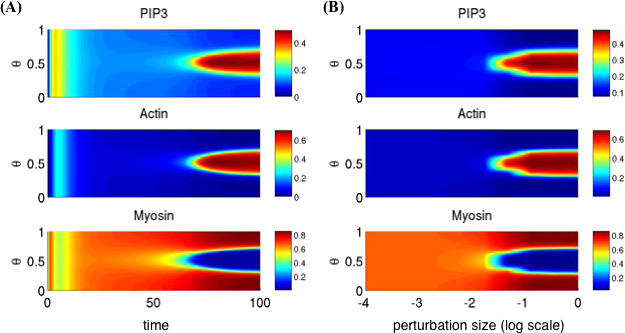
Spontaneous Polarization in Response to Uniform Addition of Chemoattractant(A) Dynamic response to the addition of chemoattractant (bL = 1 and gL = 0%) with a perturbation of magnitude 0.1 made to the receptor–ligand complex at θ = 0.5.(B) Sensitivity of spontaneous polarization to perturbation size. Steady-state distribution of PIP3, actin, and myosin in response to uniform addition of chemoattractant (bL = 1 and gL = 0%) with perturbations of increasing size made to the receptor–ligand complex at θ = 0.5.